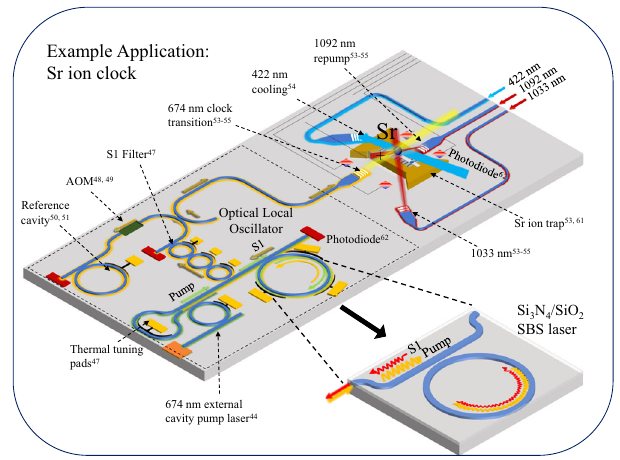
Fig. 1 Example integration application of the visible light SBS